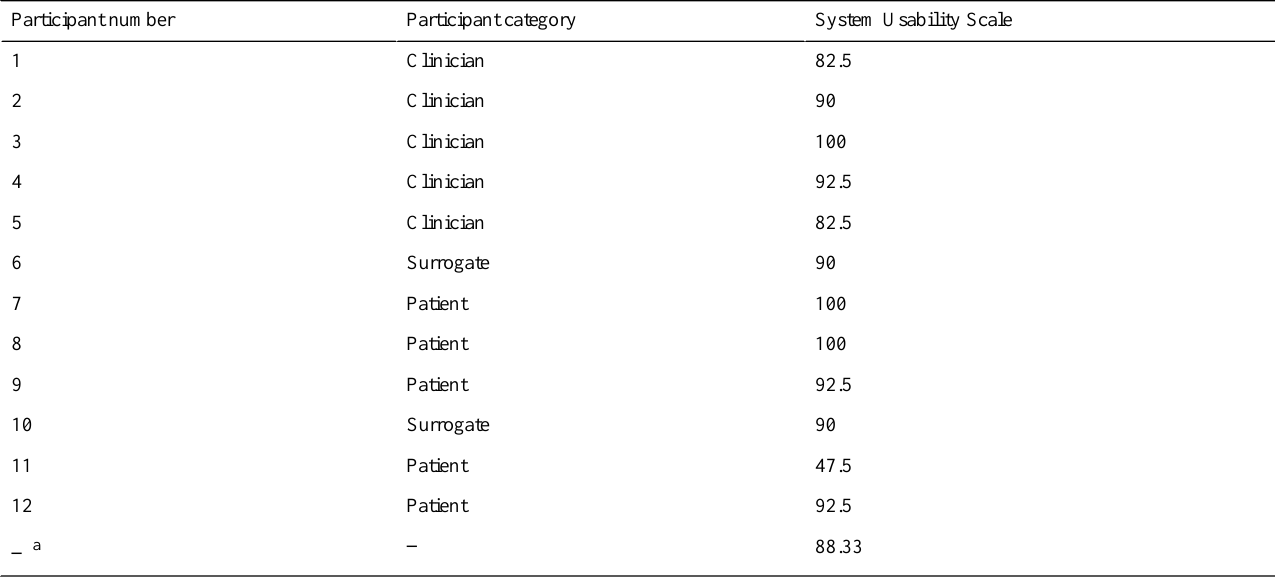
Table 2. System Usability Scale